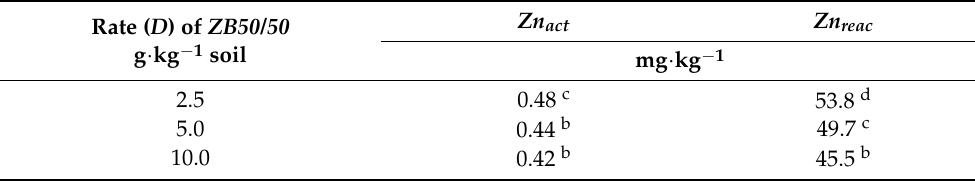
Table 7. Content of the active and reactive Zn fractions as affected by the application of the sorbent ZB50/50 , enriched with phosphorus as triple superphosphate